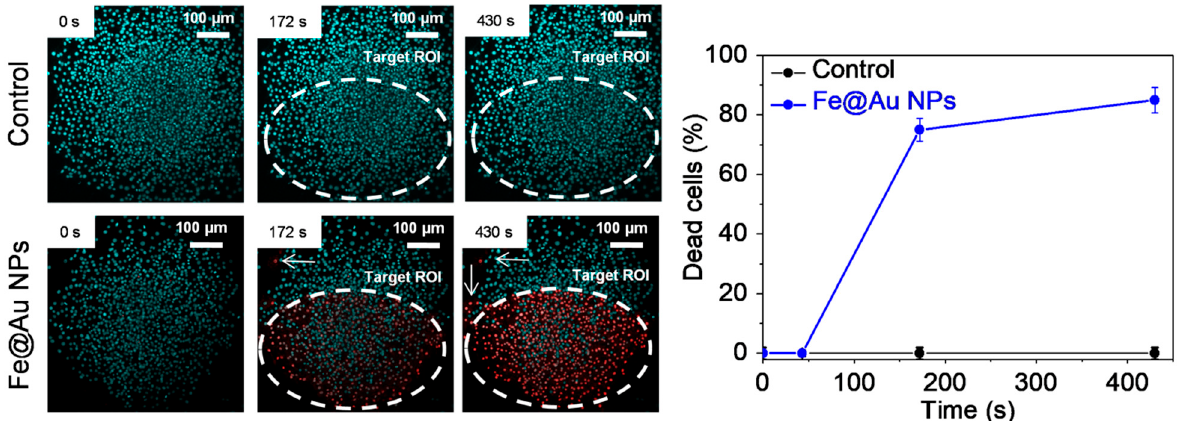
Figure 4. Left: representative images of C6 cells at different irradiation times. The TPPL process was triggered with 720 nm laser output at 10%. Top images correspond to cells exposed for 24 h to PBS and bottom images represent cells exposed for 24 h to Fe@Au NPs. The images show the merge of DAPI (blue) and PI (red) channels. Right: quantitative evaluation of dead cells percentage induction by laser irradiation.